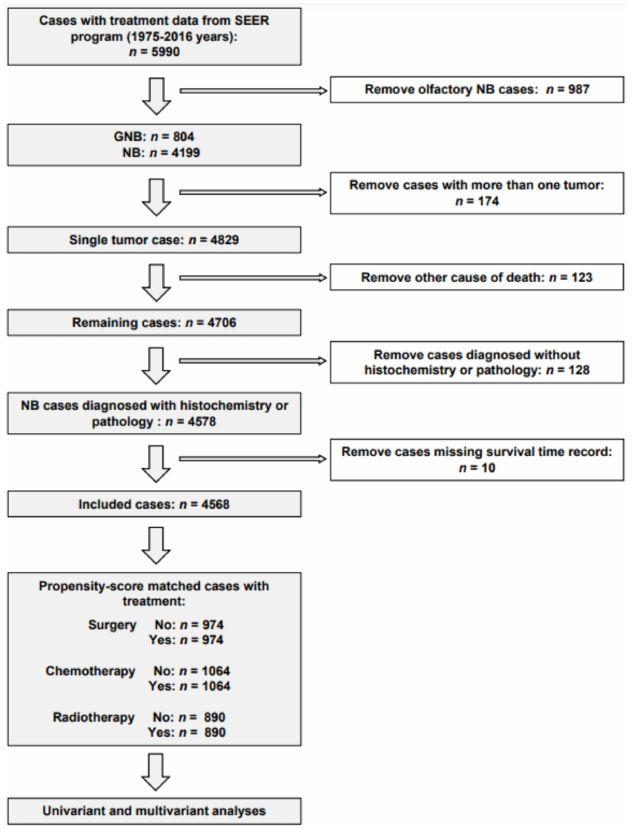
Figure 1. Process of screening of the studied data from the SEER